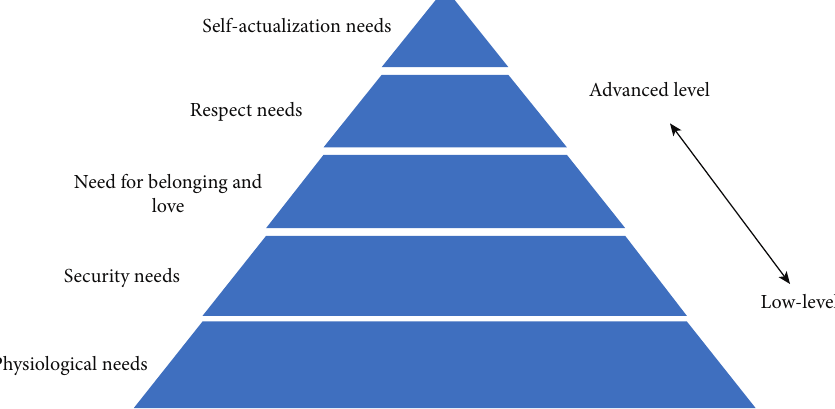
Figure 1: Demand hierarchy